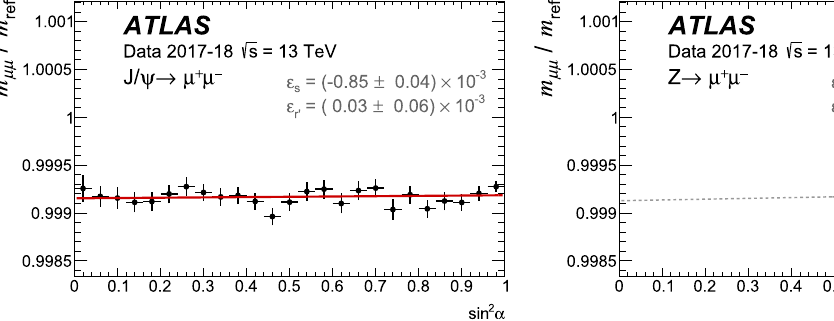
Fig. 22 Ratio of the measured mass to the reference as a function of sin 2 α . Due to event kinematics, J /ψ → μ + μ − events (left) cover the entire sin 2 α range while Z → μ + μ − events (right) cover a smaller